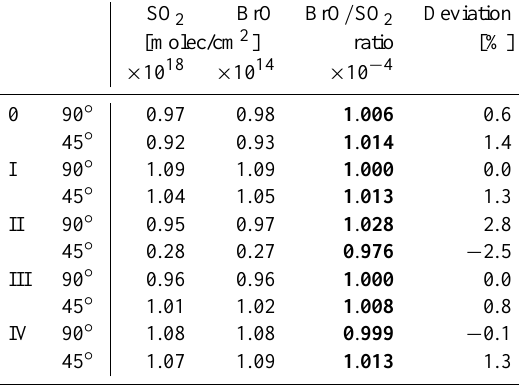
Table 2. SO 2 CDs, BrO CDs and the BrO / SO 2 ratios for the different cloud scenarios and a cloud optical density of 12 at 340nm. (0) is a cloud free atmosphere, (I) a cloud layer between 5.5 and 6.5km, (II) a cloud layer between 5 and 5.5km, (III) a cloud layer between 6.5 and 7km, and (IV) a cloud layer coinciding with the volcanic plume. SO2 BrO BrO / SO2 Deviation [molec/cm 2 ] ratio [%] × 10 18 × 10